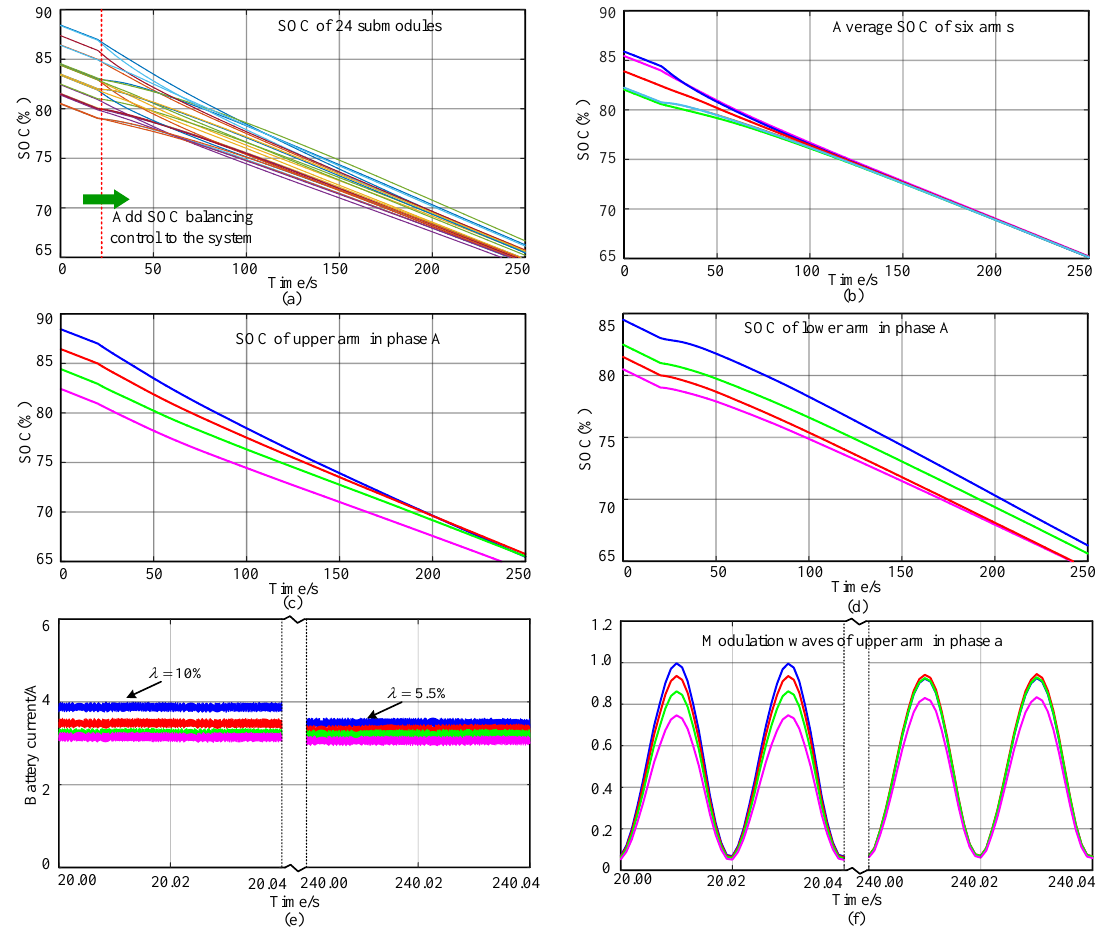
Figure 8. Simulation results of traditional SOC balancing control: ( a ) SOC of all submodules; ( b ) average SOC of six arms; ( c ) SOC of upper arm in phase a; ( d ) SOC of lower arm in phase a; ( e ) battery current of phase arm in phase a; ( f ) modulation waves of upper arm in phase A. Figure 9 is the simulation results of the proposed SOC balancing control, and the power configuration is the same as the simulation in Figure 8. The SOC of all submodules is shown in Figure 9a. At time T = 20 s, the SOC balancing control is added to the control system, and then the SOC of the whole BESS converges to the same value at around T = 200 s. Figure 9b shows the average SOC of six arms. Figure 9c,d are the SOC of upper and lower arm in phase A. In Figure 8, the tolerance for battery power unbalance is about 50%, and the control design is according to (39). At T = 20 s, the difference of SOC among submodules is the greatest, but the battery power unbalance is still limited into the allowed values and over-modulation does not